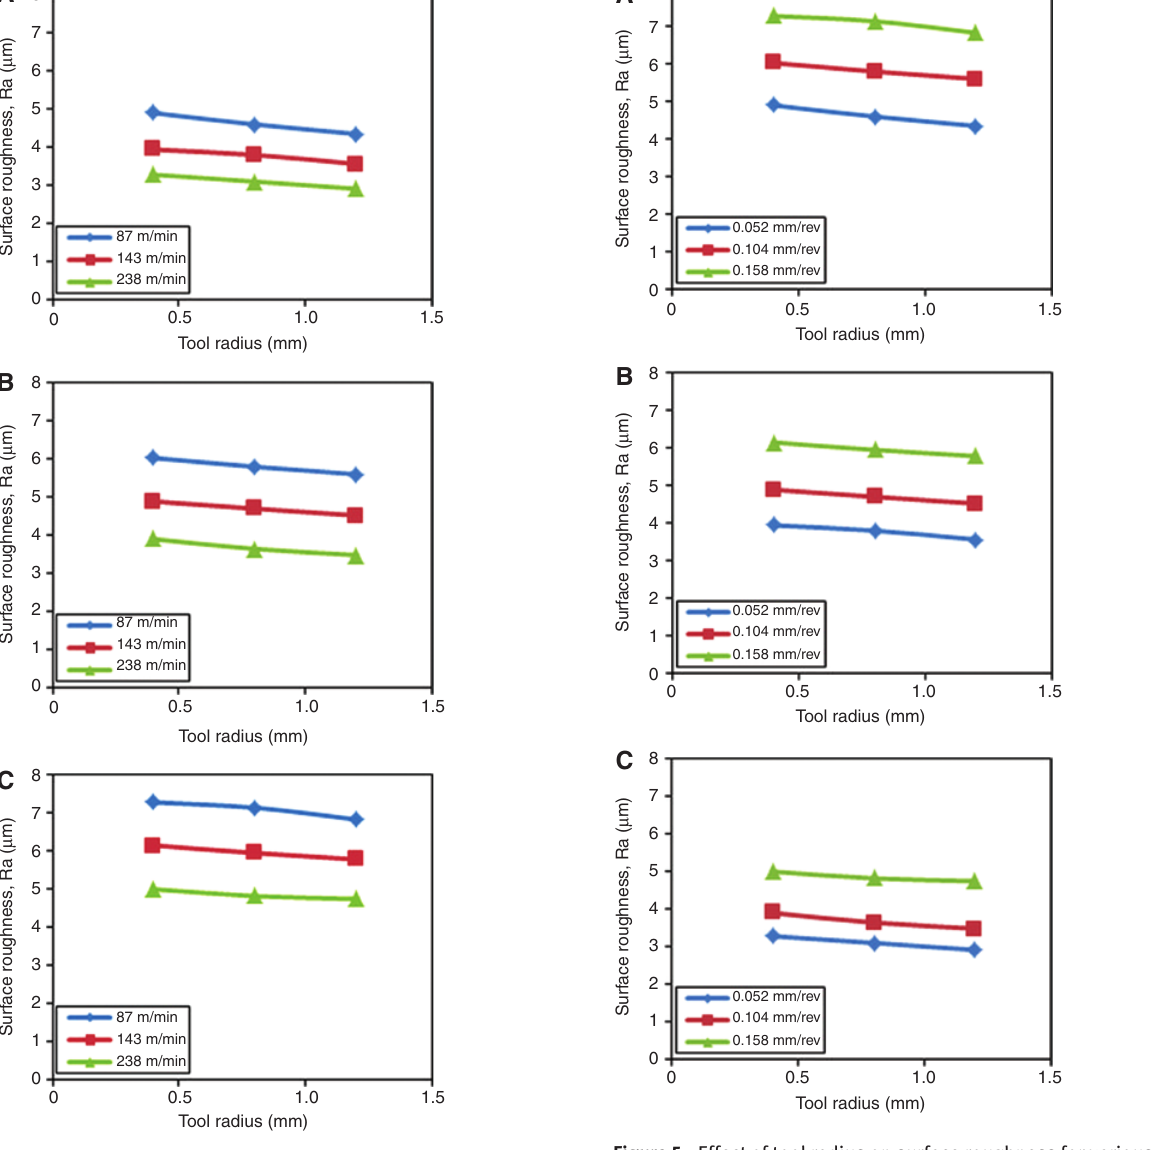
Figure 5 Effect of tool radius on surface roughness for various cutting speeds: (A) 87 m/min, (B) 143 m/min, and (C) 238